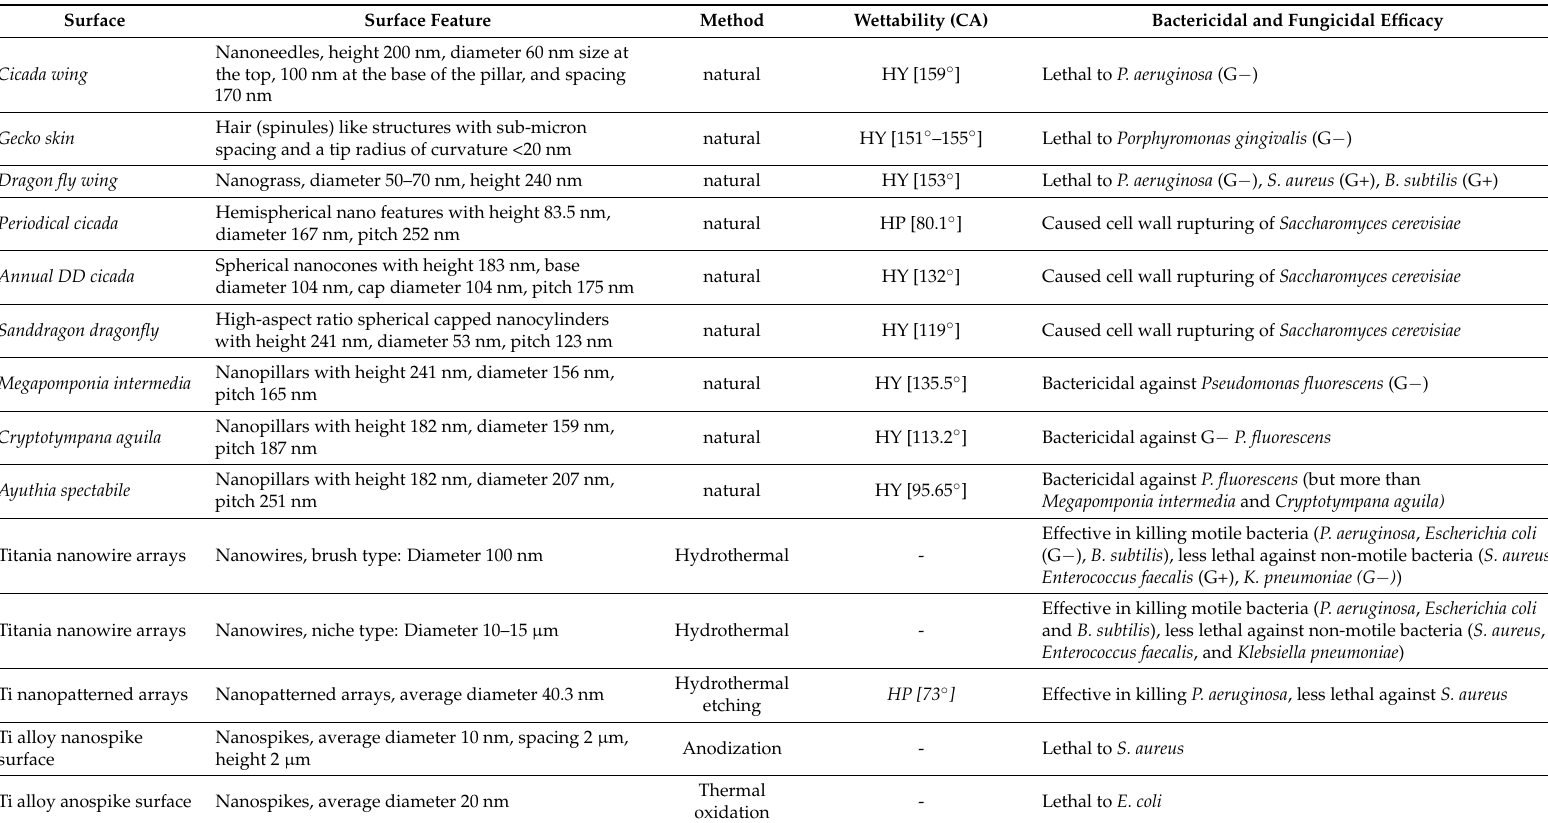
Table 4. Natural nanostructures and bio-inspired Ti structures modified from [155,184–187]. In contrast to hydrophilic surfaces hydrophobic surfaces prohibit bacterial growth as the bacteria cannot stick to the surface. Defined nanostructured surfaces can stretch and rupture the relatively thin bacterial cell wall. This rapid morphological change of the adhered bacteria induce its death within a few minutes (approximately 3–5 min, “contact killing mechanism”). However, the peptidoglycan layer of the cell wall of Gram-positive (G+) bacteria is 4–5 times thicker than that of Gram-negative (G − ). Here, defined surface textures of the nanostructure are required to enfold its bacteriostatic effects which are based on reduced adhesion forces. A special challenge and exception are mycobacteria. In contrast to many other bacteria their cell wall is thicker, hydrophobic, and rich in mycolic acids. It is believed that, for this reason, there has not been any study